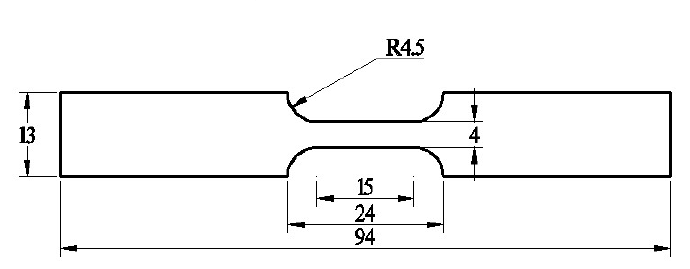
Figure 4. Dimensions of dog-bone shaped sample (according to ASTM D638, Type IV).